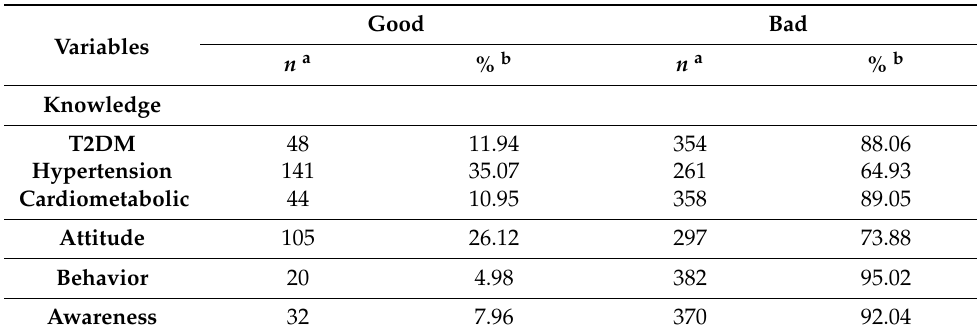
Table 2. KAB and awareness of participants on cardiometabolic diseases ( n =